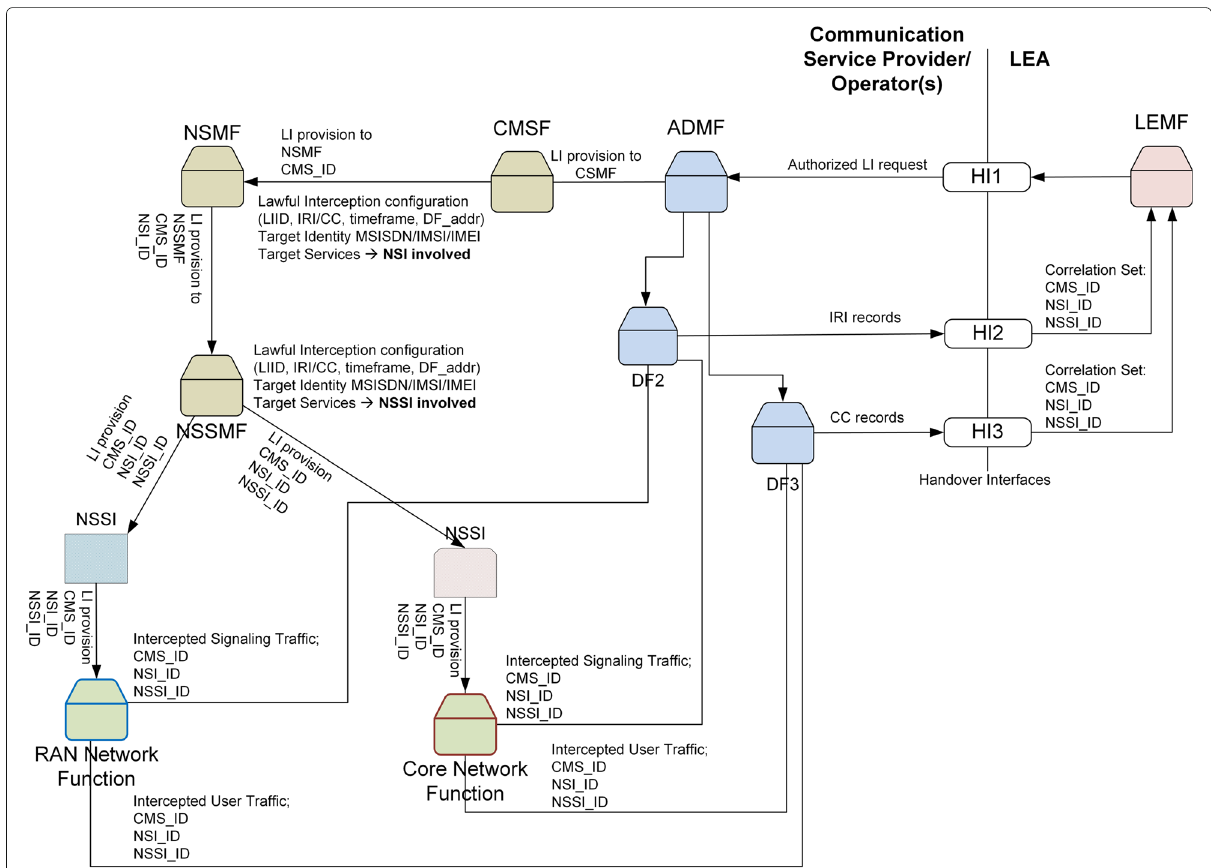
Fig. 12 LI adaptations for the Rel. 15 network slicing architecture. For the LEA to be able to distinguish and correlate CIoT traffic (signaling and both IP and non-IP traffic), a triplet of IDs including the communication service identifier, the NSI identifier, and the NSSI identifier is